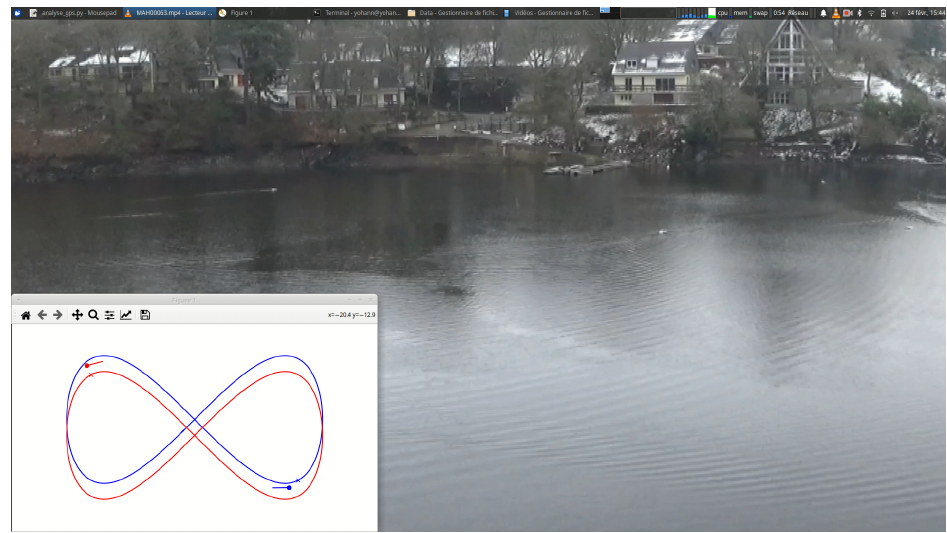
Figure 2. Reference trajectories of both DDboats and video snapshot of the experimental data